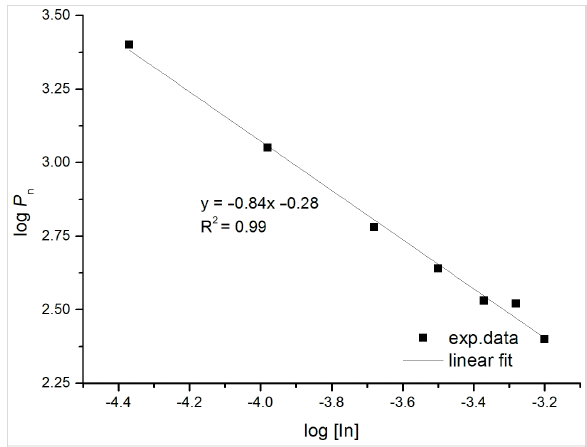
Figure 2: Plot of log P n versus log [In] of the polymerization of MLA with different mol % AIBN.